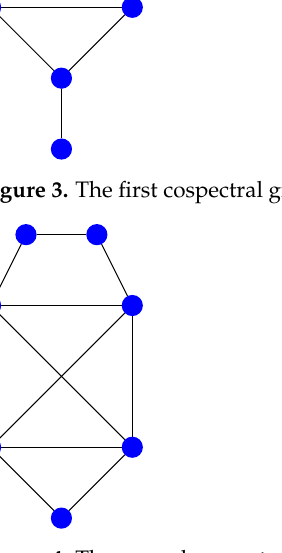
Figure 4. The second cospectral graph with seven